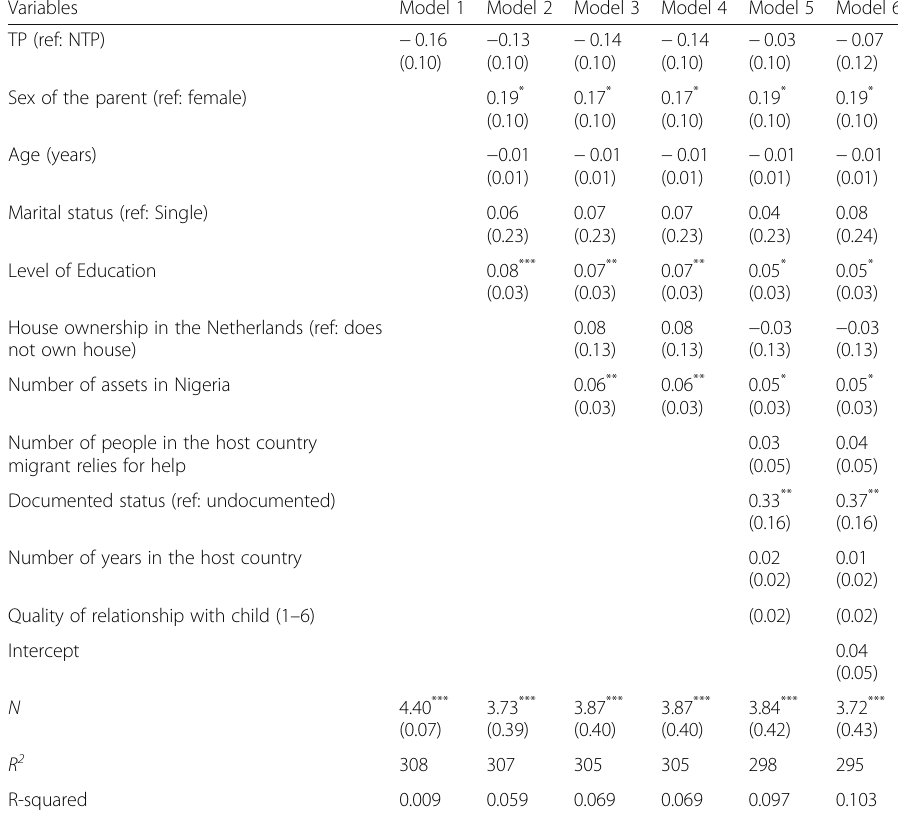
Table 3 Ordinary least squares regressions predicting self-assessed Health, Ireland